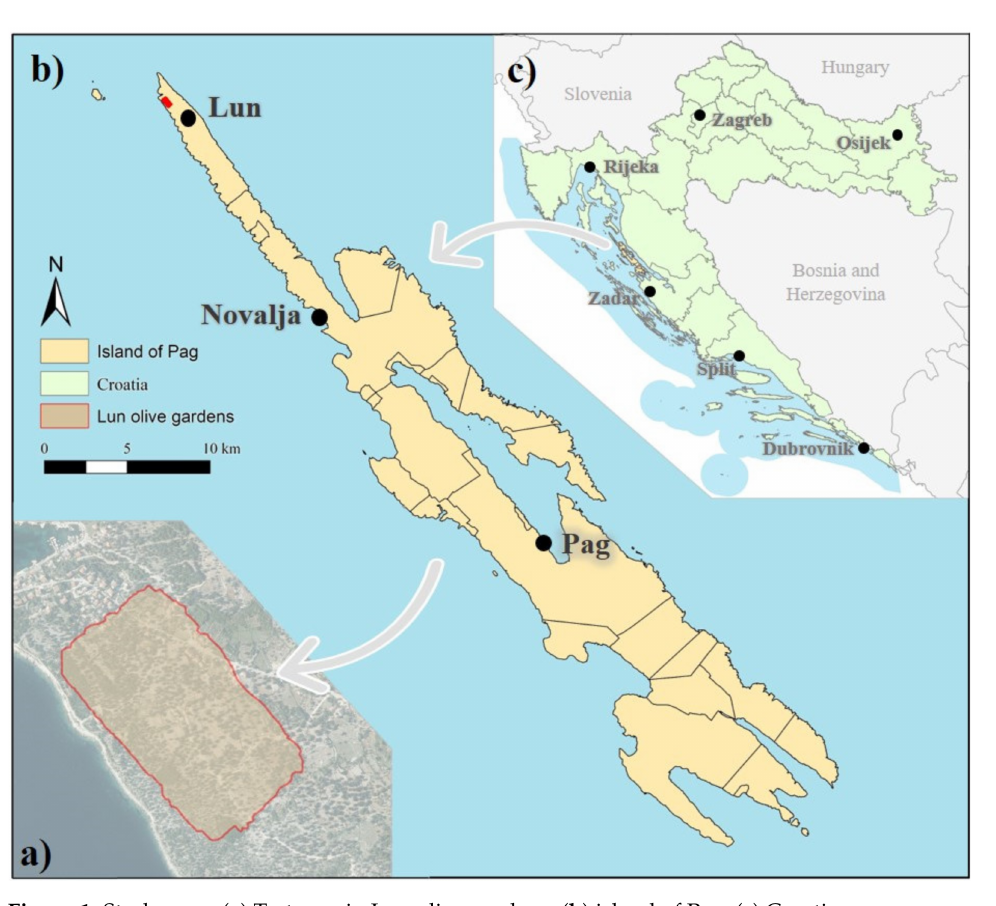
Figure 1. Study area: ( a ) Test area in Lun olive gardens; ( b ) island of Pag; ( c )